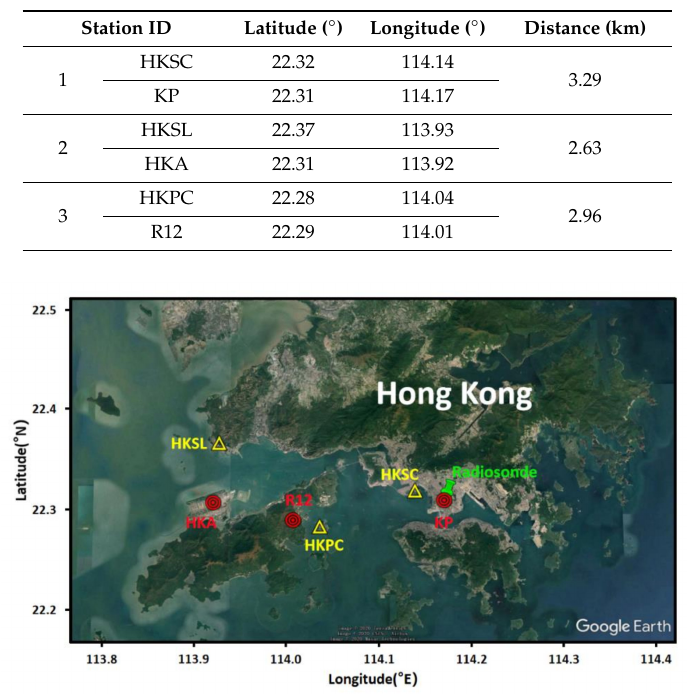
Figure 1. Geographical distribution of three GNSS stations (yellow triangles) and their co-located weather stations (red dots), as well as the radiosonde station (green tag) in Hong Kong (The equidistant cylindrical projection is adopted in this figure plotted by Google Earth